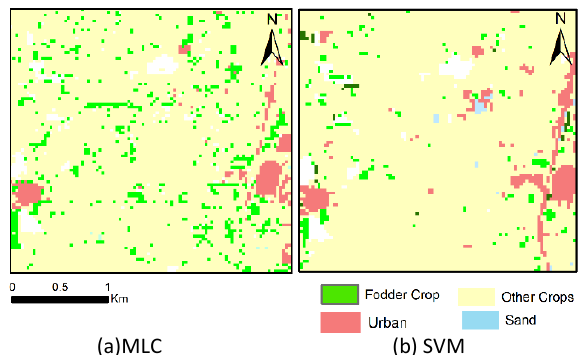
Figure 6. Speckle effect is significantly higher in MLC as compared to SVM for the same